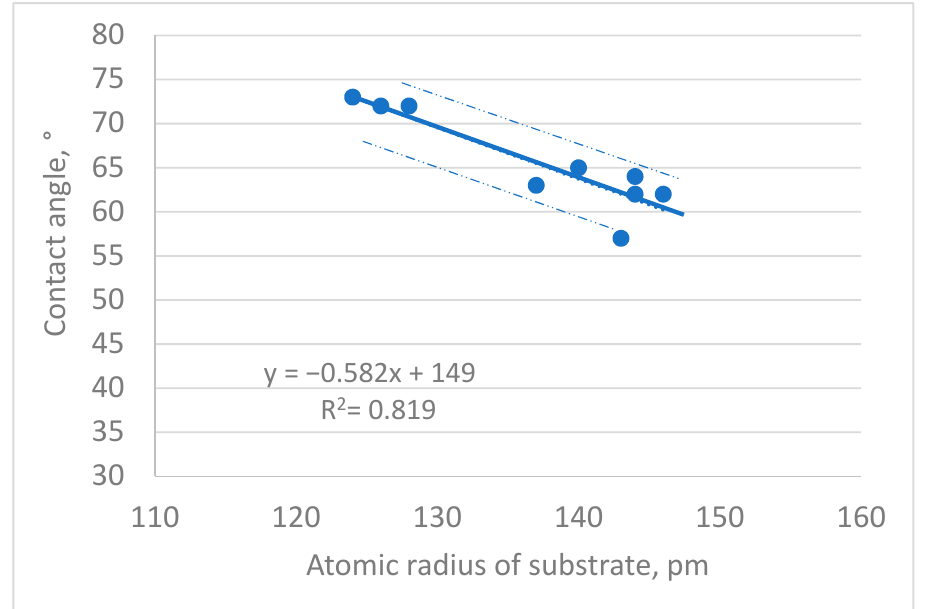
Figure 4. The contact angle of distilled water as a function of the atomic radius of the substrate.